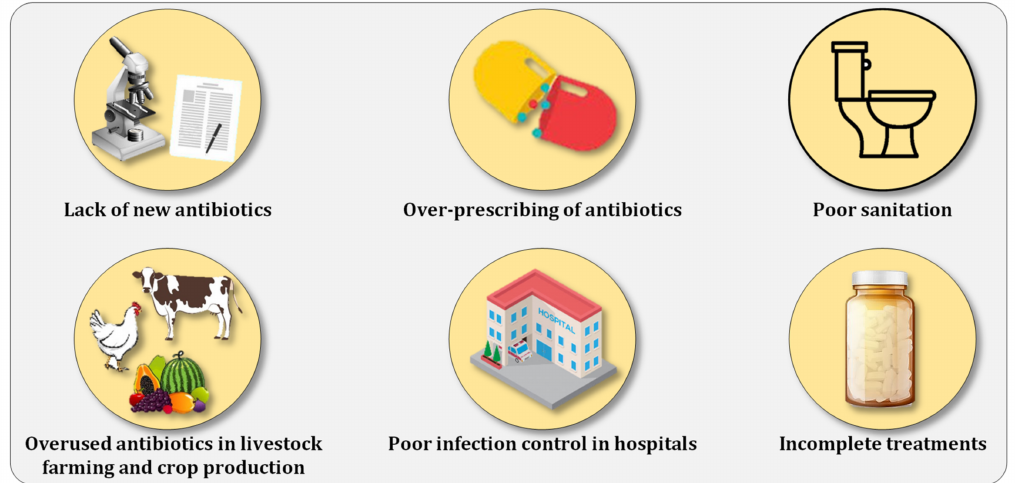
Figure 1. The most consequential causes of AMR, adapted from the World Health Organization (WHO)